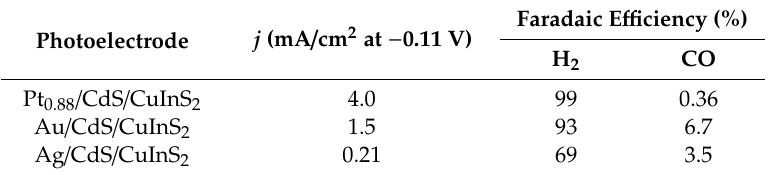
Table 1. Photoelectrochemical CO 2 reduction using CdS / CuInS 2 electrodes modified with noble metal